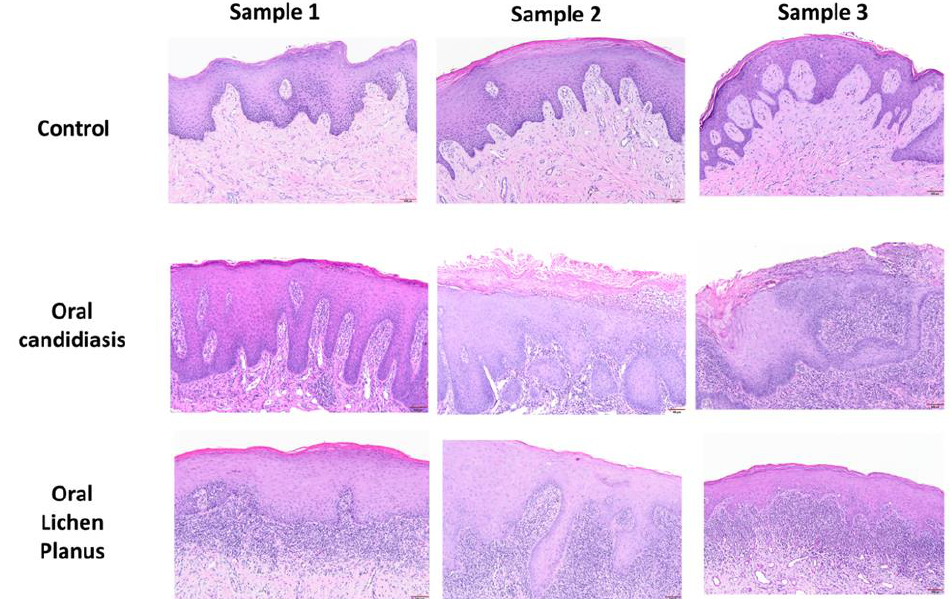
Figure 1. Panels show H&E staining of three tissue specimens from each experimental group confirming presence of marked immune and inflammatory cells in oral candidiasis and oral lichen planus compared to control tissues. Scale bar: 100 μm.